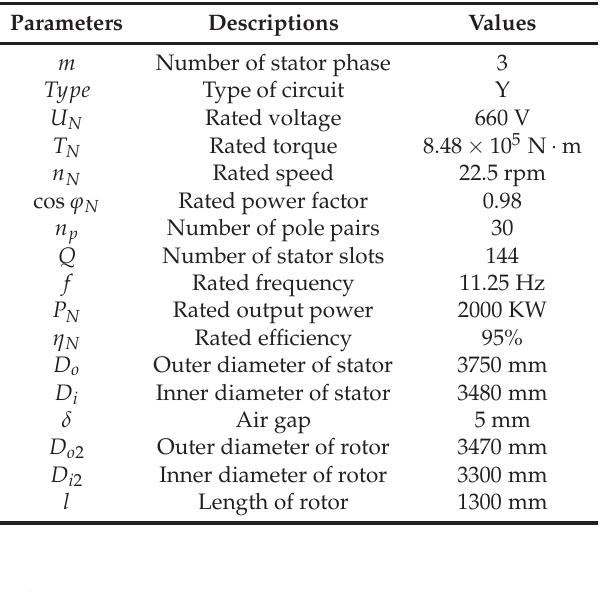
Table 2. Direct-driven surface-mounted permanent magnet synchronous generator (D-SPMSG) design requirements: rated parameters and main dimensions.